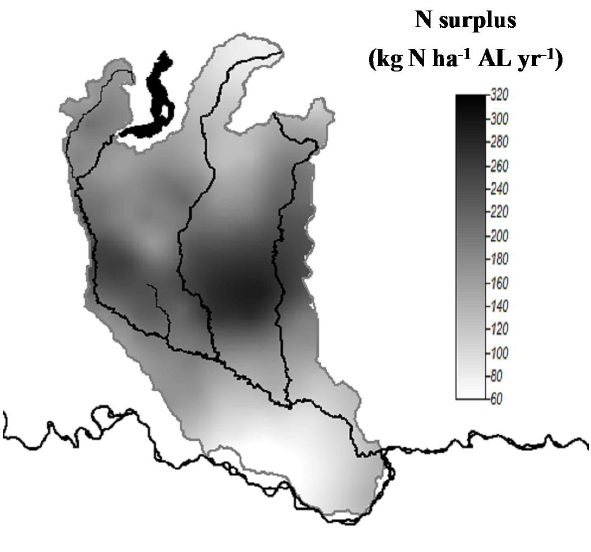
Fig. 3. Spatial distribution of N surplus (=difference between N in- put and N output terms in a soil system budget) within the Oglio River watershed. Values of the N surplus were assigned to the cen- troid of all the over 250 municipalities within the basin and then in- terpolated by means of the ordinary kriging technique. Calculations were performed with the GIS software SAGA (System for Auto- mated Geoscientific Analyses, version 2.0.5, http://www.saga-gis. org). Data refers to budget calculations performed for the year